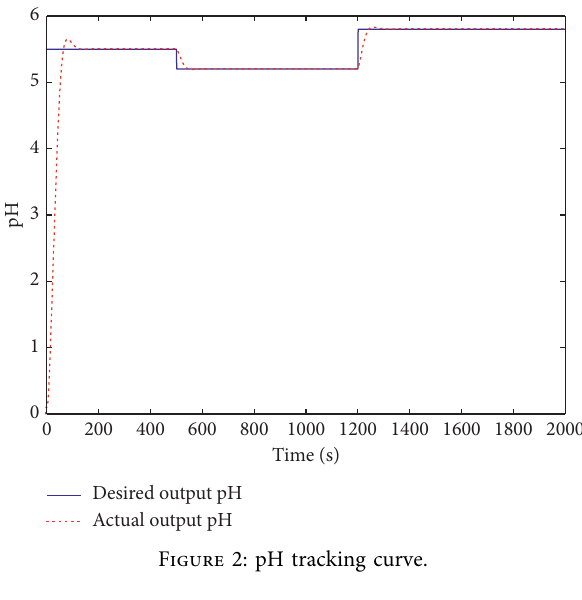
Figure 2: pH tracking curve.